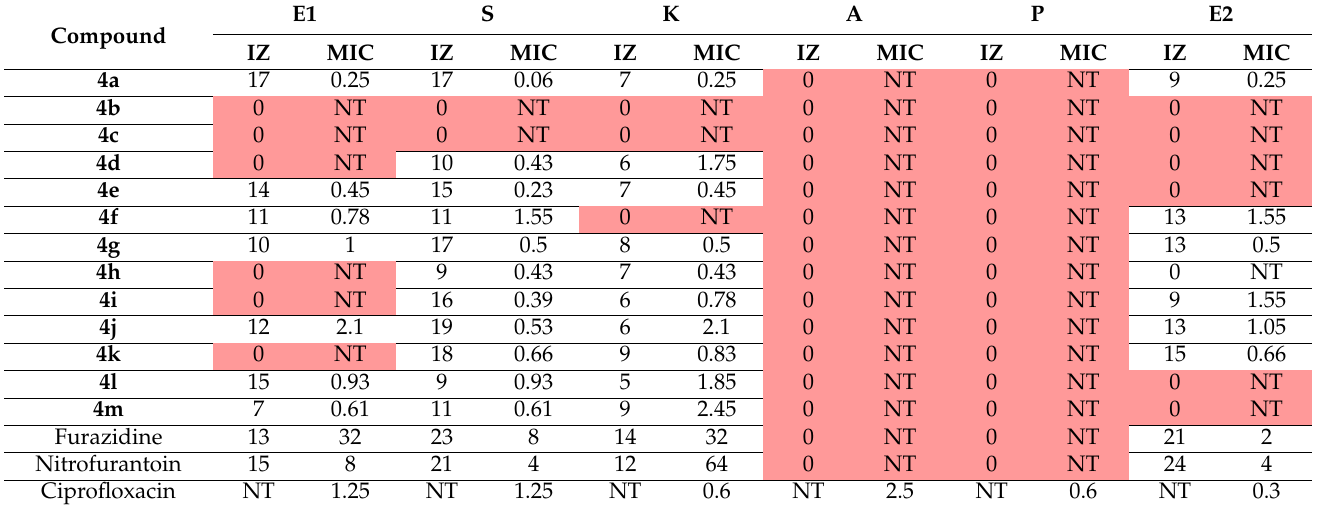
Table 1. Antibacterial activity (disk diffusion method inhibition zone (IZ, mm) and minimal inhibitory concentration (MIC, µ g/mL) of compounds 4a–m , nitrofurans furazidine and nitrofurantoin as well as ciprofloxacin (positive controls) against the ESKAPE panel of pathogens (E1 = Enterobacter cloacae (G − ), S = Staphylococcus aureus (G+), K = Klebsiella pneumoniae (G − ), A = Acinetobacter baumannii (G − ), P = Pseudomonas aeruginosa (G − ), E2 = Enterococcus faecalis (G+)); NT—not tested. The compounds that were not tested or having no activity are marked red. The MIC values are mean from three different assays (errors were in the range of ± 5–10% of the reported values).